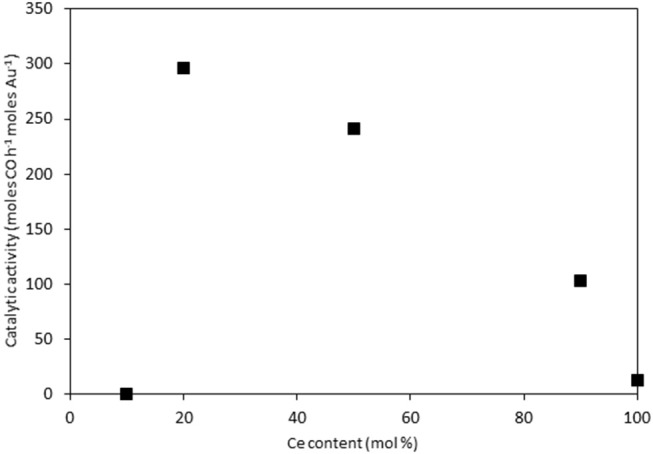
LTS activity for Au/CexTi1−xO2 catalysts after 90 min on-stream: 0.150 g catalyst, 150°C, 100 ml min−1, 2% CO, 2% CO2, 7.5% H2O, 8.1% H2, 80.4%N2.